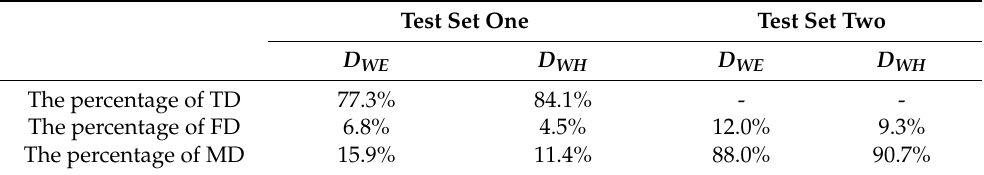
Table 5. The performance of the proposed method.